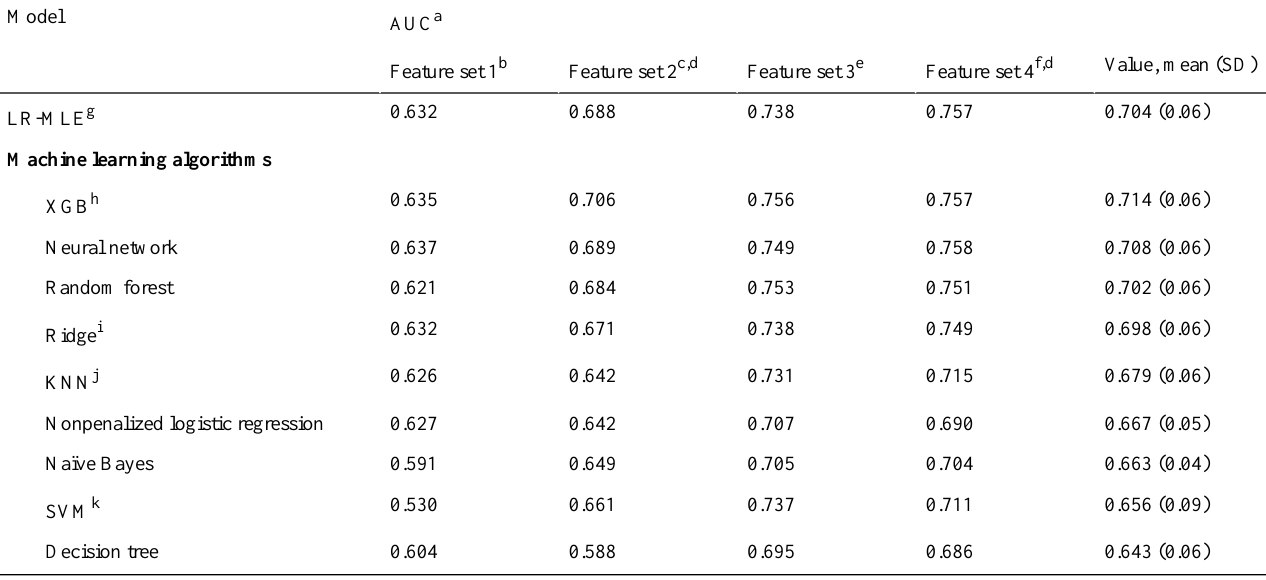
Table 2. Diagnostic accuracy for logistic regression with maximum likelihood estimation and the 9 machine learning algorithms using feature sets 1 to 4 with the test data